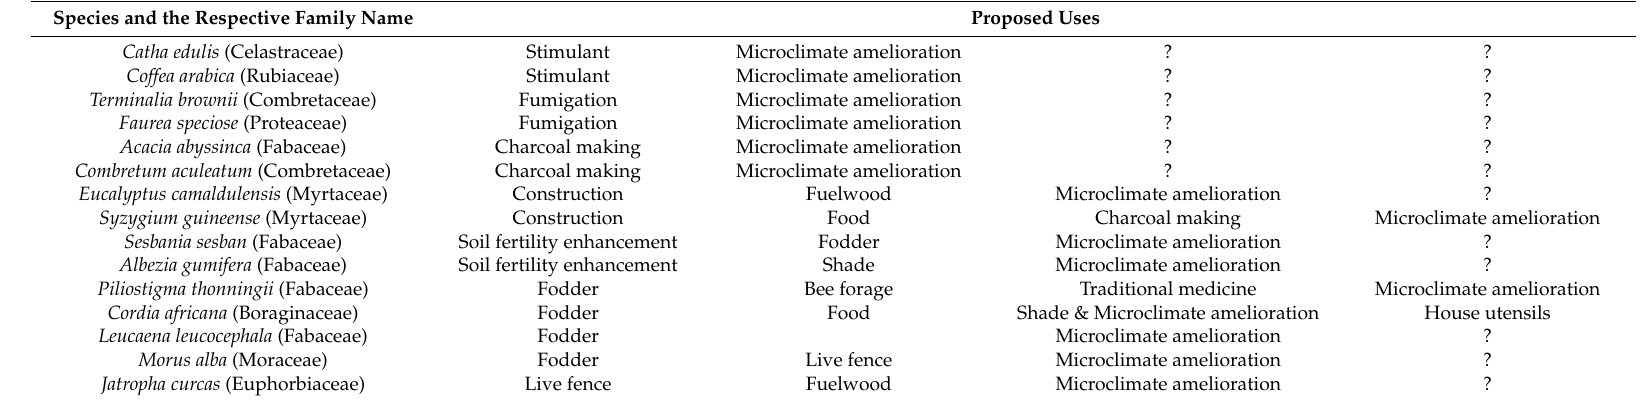
Table A4. Major woody and herbaceous perennial species and their uses in Assosa district, western Ethiopia as stated by the households. “?” stands for other purposes not mentioned by the